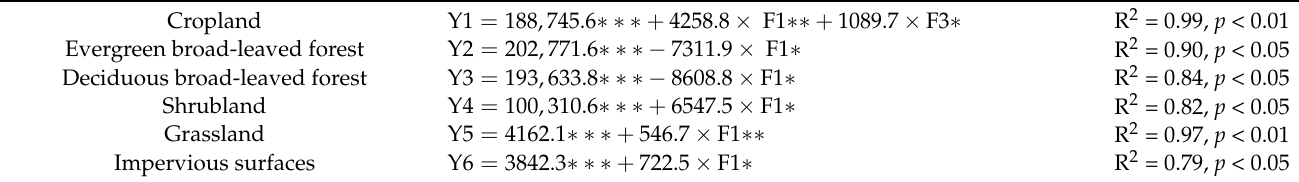
Table 5. The relationship between the area of different LUC types and the three principal components.